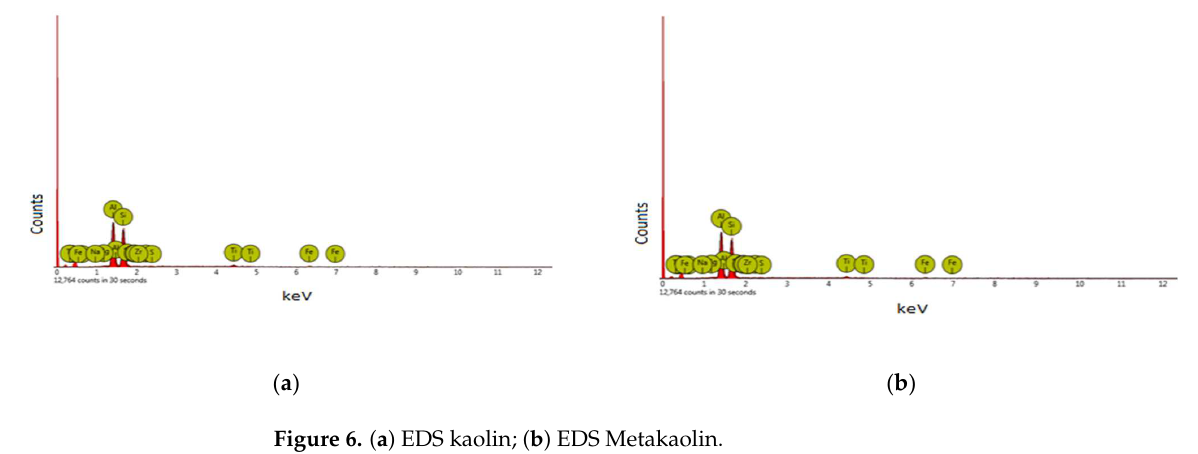
Figure 6. ( a ) EDS kaolin; ( b ) EDS Metakaolin.